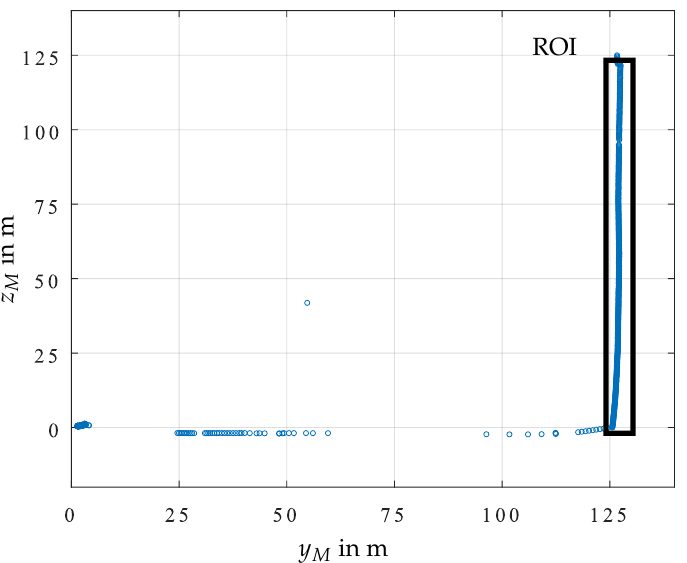
Figure 2. All detected points with the vertical scanner alignment in the measurement coordinate system ( y M , z M ) . The points on the tower are marked as the region of interest (ROI).